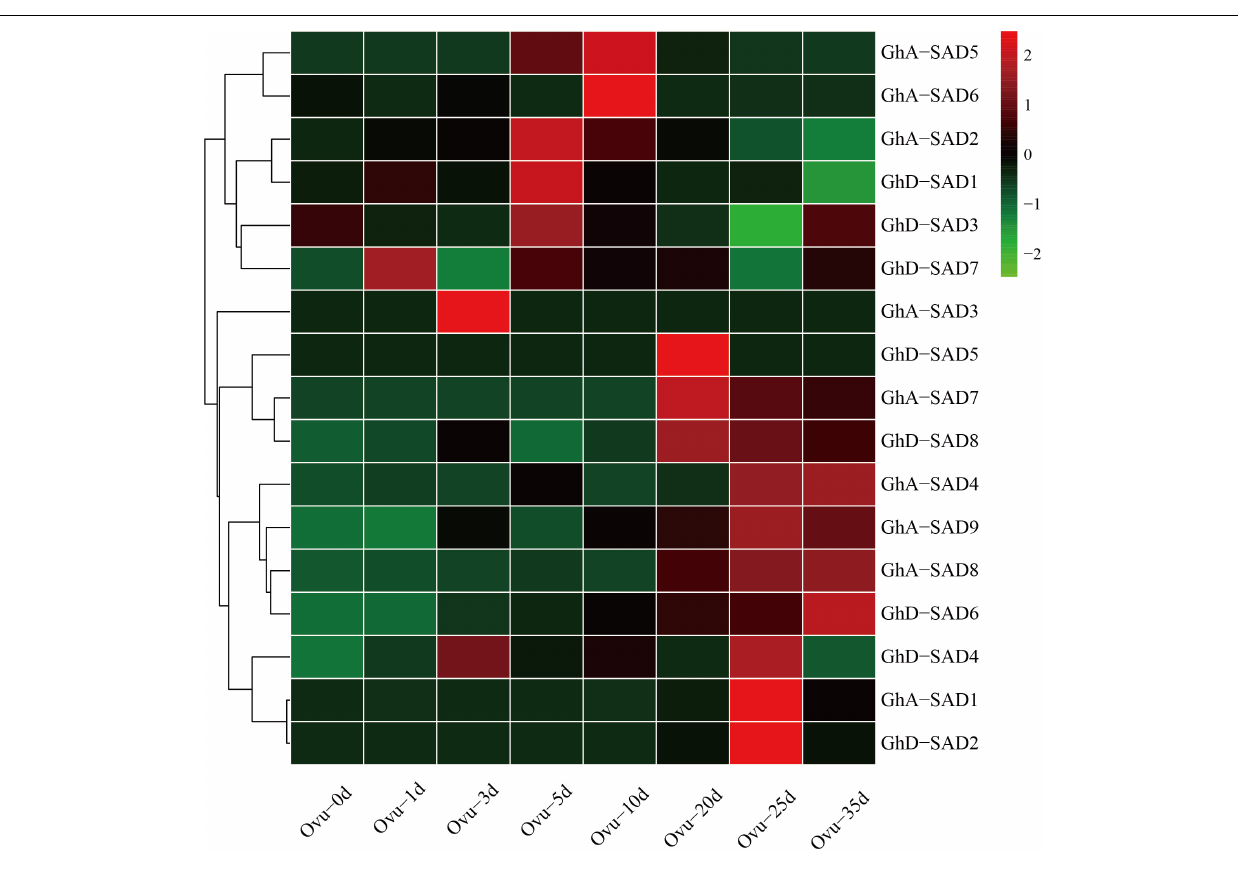
of GhA-SAD6 and GhD-SAD8 were integrated into one figure ( Figure 6 ). In the embryo, neither 16:1 (cid:49) 9 nor 18:1 (cid:49) 9 content change was obviously correlated with the expression level of either GhA-SAD6 or GhD-SAD8 gene ( Figures 6A,C ). In the endosperm, no correlation was also detected between 18:1 (cid:49) 9 content and the two gene expressions ( Figure 6D ). However, a significantly positive correlation was detected between 16:1 (cid:49) 9 content and GhA-SAD6 or GhD-SAD8 expression in the endosperm fractions ( Figure 6B ). Moreover, linear regression analysis also showed that the level of palmitoleic acid in the endosperm is positively correlated with the expression of GhA- SAD6 ( r = 0.752) and GhD-SAD8 ( r = 0.886), respectively, again indicating that GhA-SAD6 and GhD-SAD8 may be the